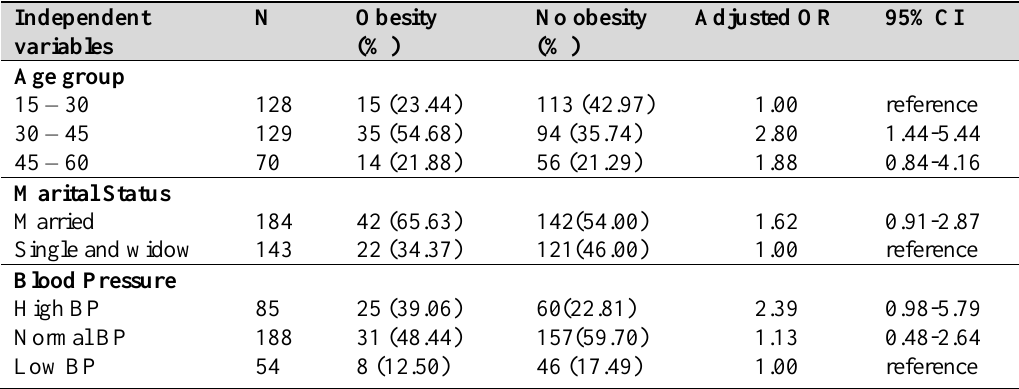
Table 2. Relationship between the analyzed factors and the risk of being obese in Anonkoi